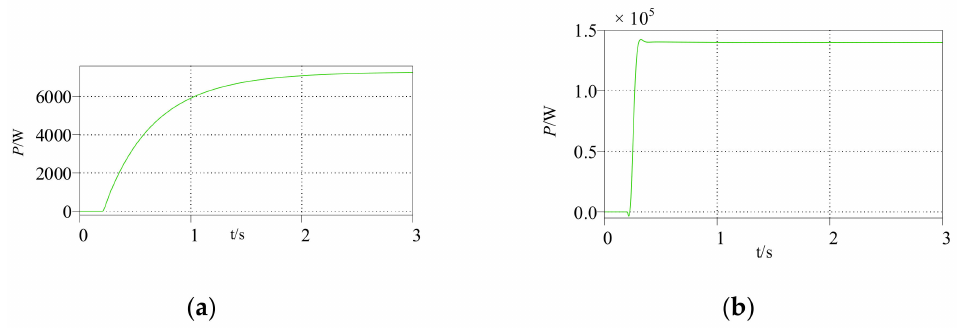
Figure 11. ( a ) Active power of a GFM converter ( P set = 7000 W, SCR = 1.45); ( b ) active power of a GFM converter ( P set = 140,000 W, SCR = 29.04).